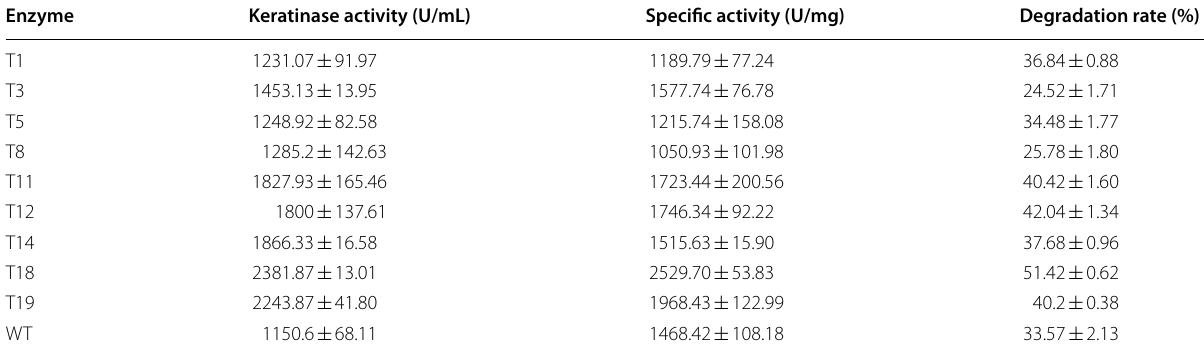
Table 1 Comparison of the performance indexes of mutant strains and WT Enzyme Keratinase activity (U/mL) Specific activity